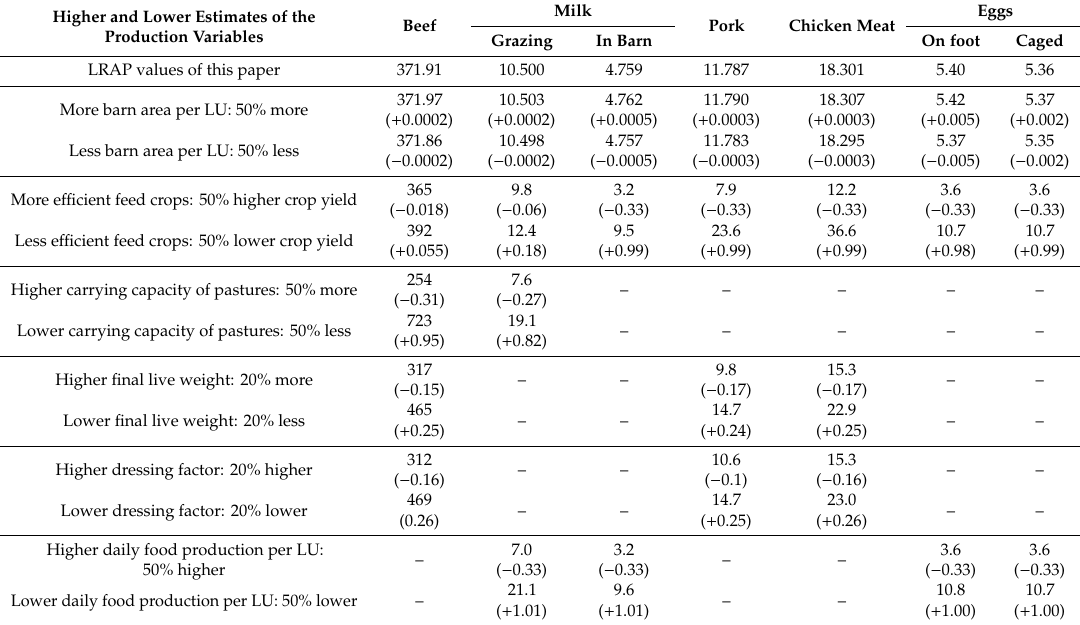
Table 11. Sensitivity analysis of the production variables to calculate the LRAP. Values expressed LRAP calculated in this paper. Deviation calculated by dividing the di ff erence between LRAP of the assumption and the LRAP calculated in this paper by the LRAP calculated in this